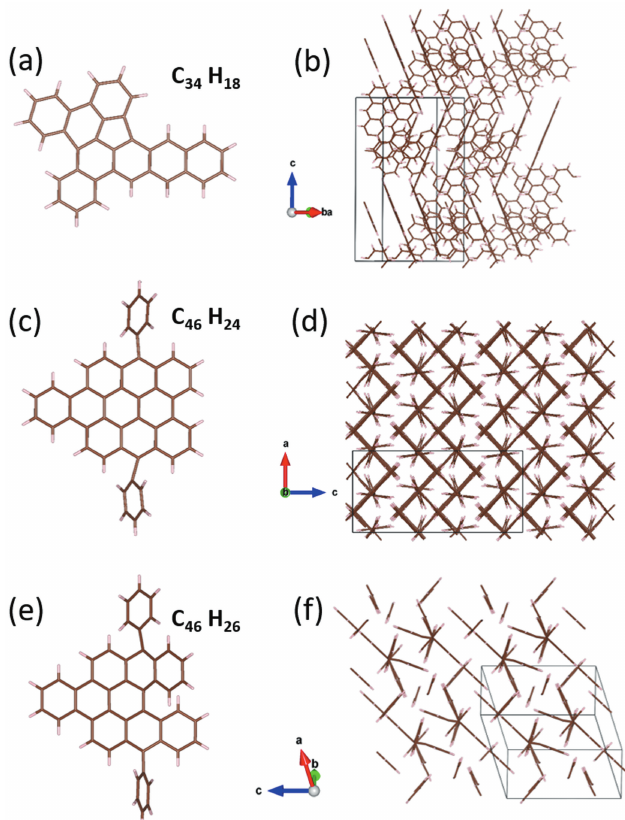
Figure 7 The molecular configuration and crystalline structure of ( a )/( b ) com- pound I, ( c )/( d ) compound VI and ( e )/( f ) compound VII. C atoms are shown in brown and H atoms are shown in light